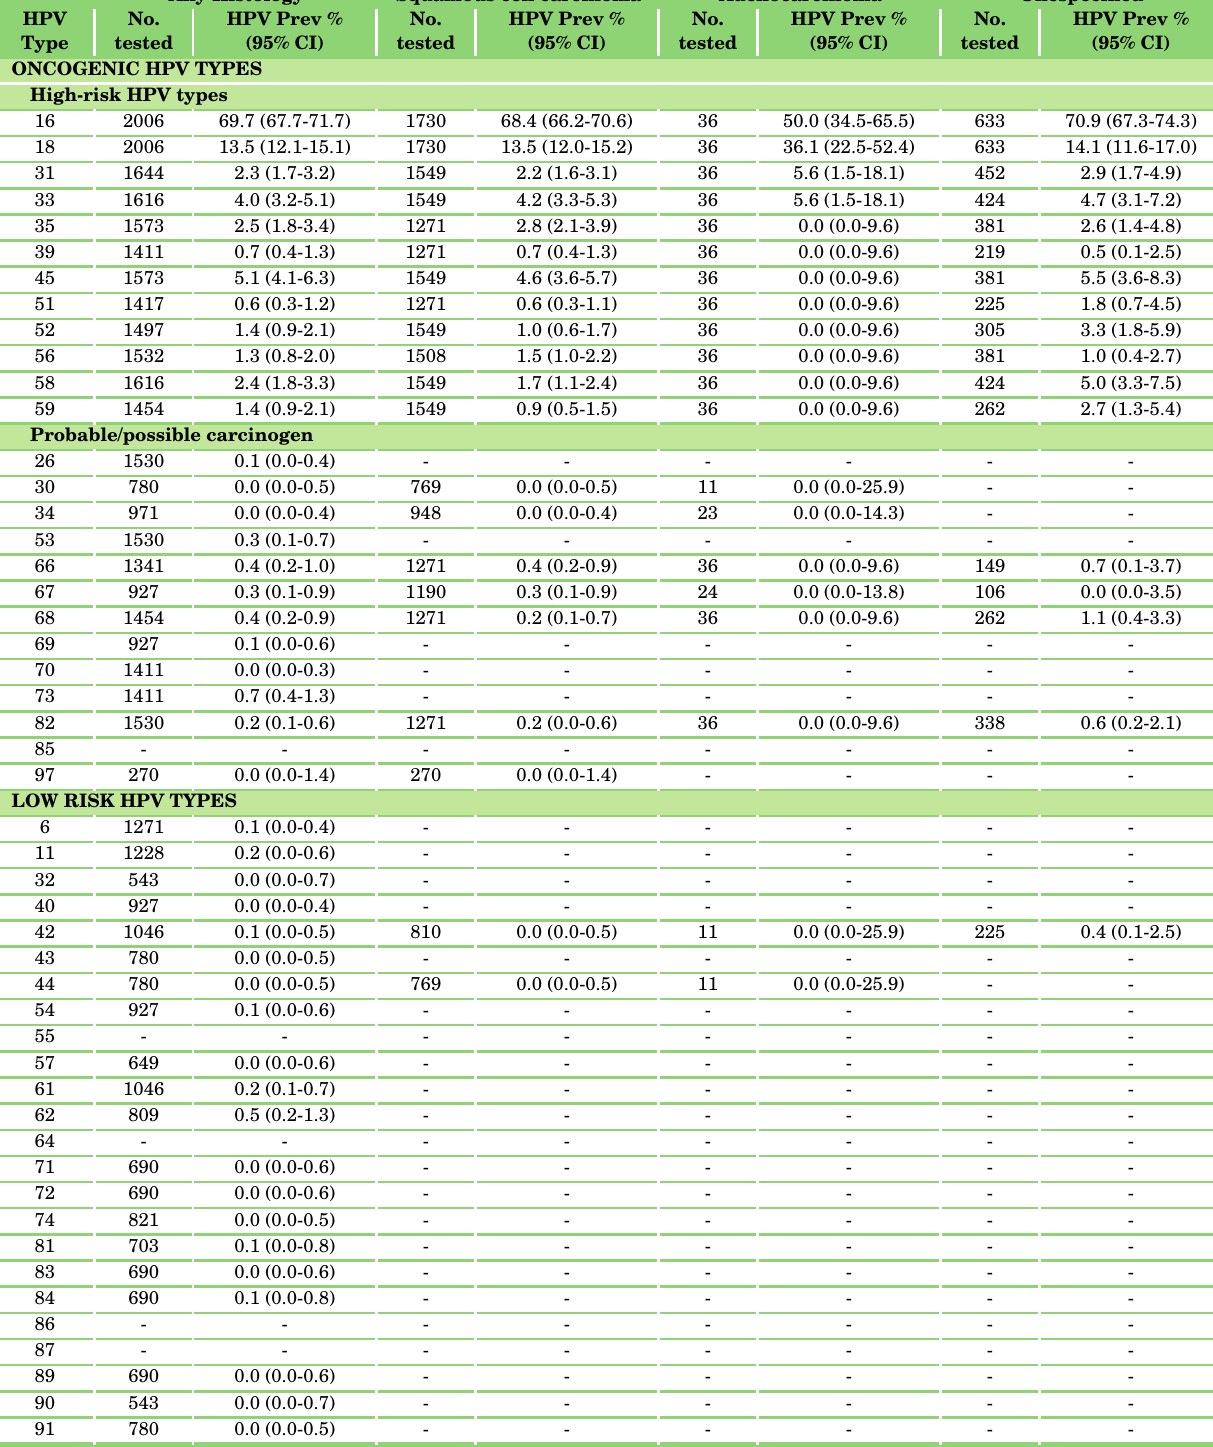
Table 23: Type-specific HPV prevalence among invasive cervical cancer cases in India by histology Any Histology Squamous cell carcinoma Adenocarcinoma